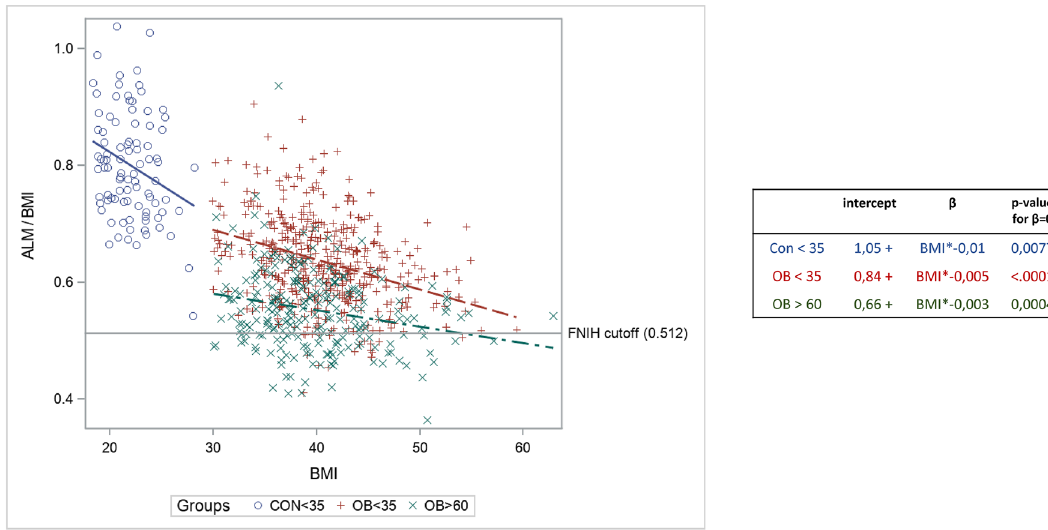
Figure 3. Regression curve of ALB/BMI accordibg to BMI values and obesity status. ALM: appendicular lean mass (sum of the lean soft tissue mass for the arms and legs), BMI: body mass index; FNIH: foundation for the